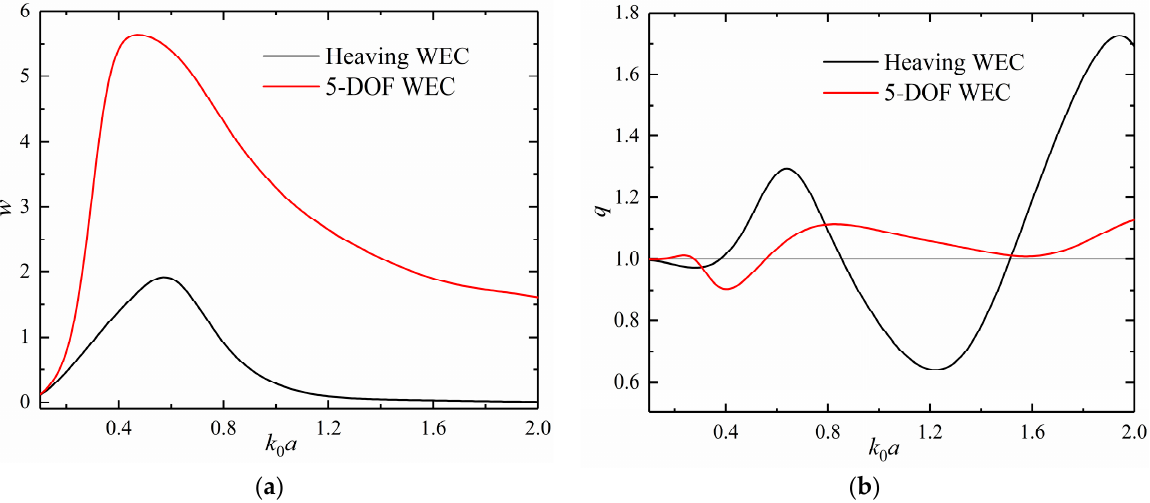
Figure 8. The performance of an array composed of two WECs perpendicular to the incident wave: ( a ) capture width; ( b ) interaction factor. Heaving WEC: each WEC moves and extracts power in heave mode only; 5 ‐ DOF WEC: each WEC moves and extracts power in five degrees of freedom.